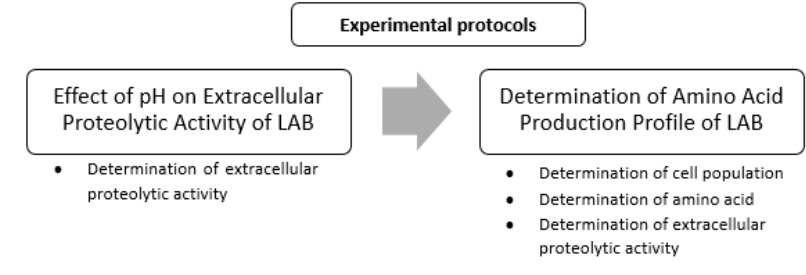
Figure 4. Overall experimental protocols .